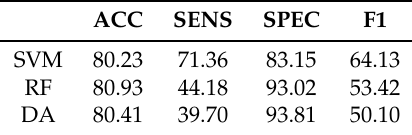
Table 2. Classifiers’ assessment metrics obtained by cross-validation across the entire dataset containing WM and PR recordings for the selected analysis time of 15 s, overlapping time of 10 s, and N = 3.